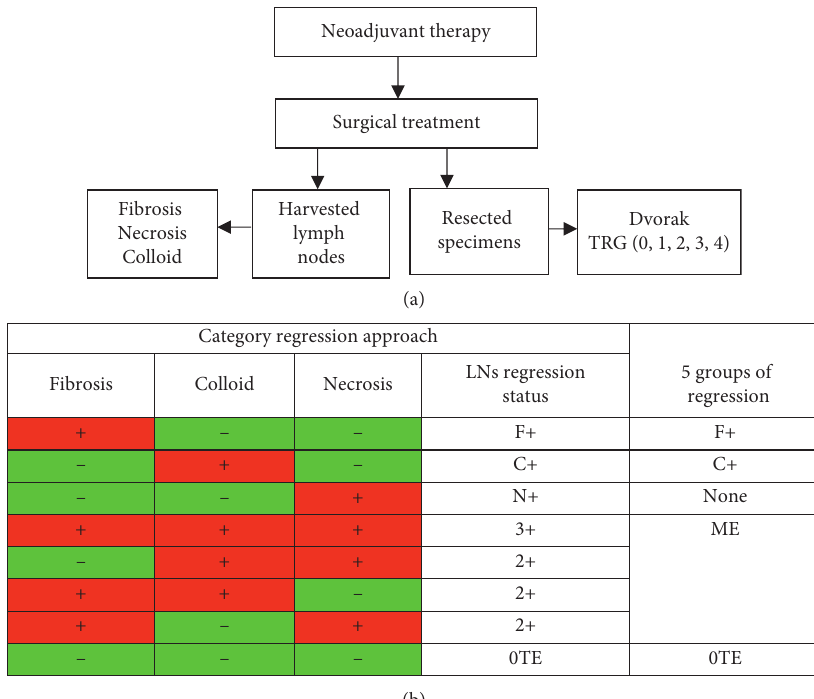
Figure 1: Illustration of lymph nodes regression on categorical approach. (a) Chart illustration of patient strategy enrollment. (b) As- signment of categorical regression approach, defining lymph nodes regression status. TE: therapeutic effect; LNs: lymph nodes; 0TE: absence of therapeutic effect; 2+: combination of two therapeutic effect types; 3+: combination of three therapeutic effect types; F+: fibrosis effect; C+: colloid effect; N+: necrosis effect; ME: mixed